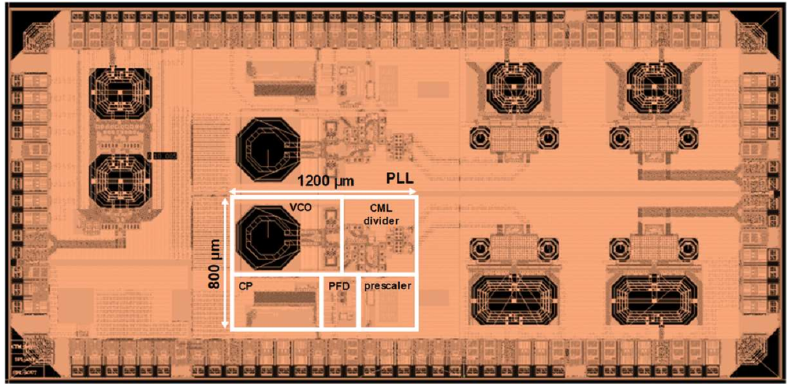
Figure 7. Layout of the proposed